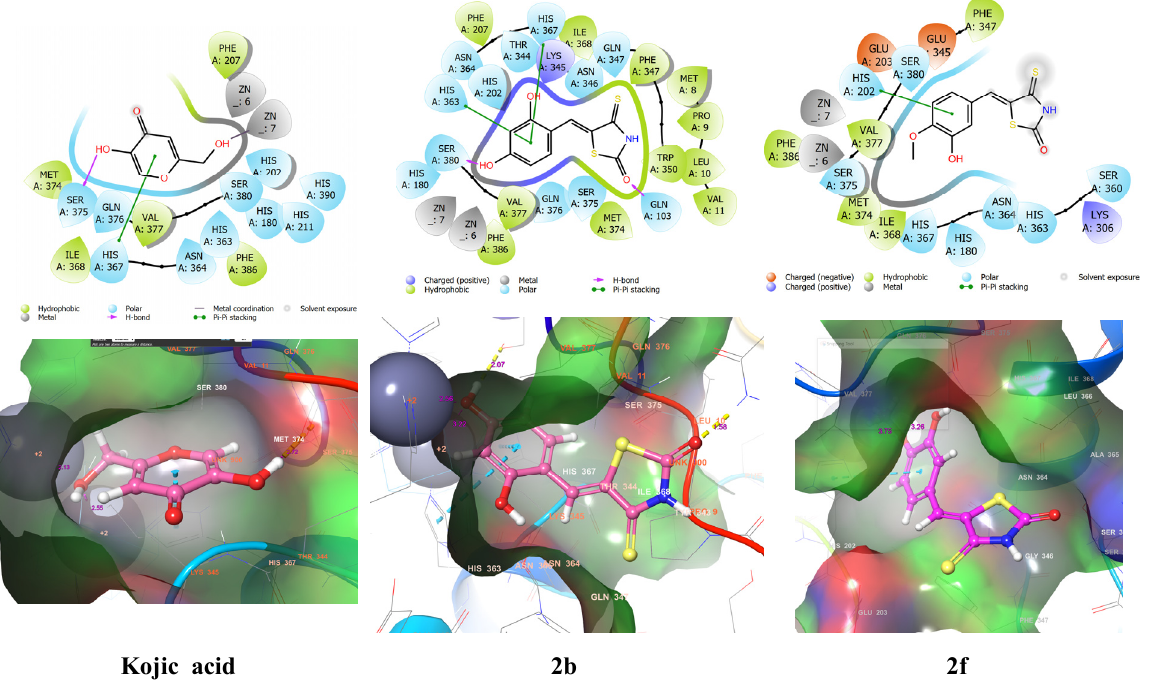
Figure 6. Expected binding modes of compounds 2b , 2f, and kojic acid in the h TYR homology model using Schrödinger Suite. The 2D and 3D conformations of 2b , 2f , and kojic acid are shown, respectively.